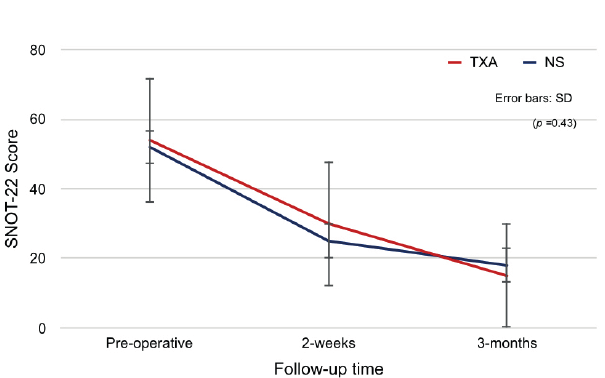
Figure 4. Objective CRS. Severity measures (LMS and MLMES) over time. LMS = Lund-Mackay Score; MLMES = Modified Lund-Mackay Post- operative Endoscopie Score: TXA = Topical Tranexamic acid; NS= topicaJ normal saline; Error bars indicate standard deviation (SD): p-values are based on Mixed Between-Within Subjects Analysis of